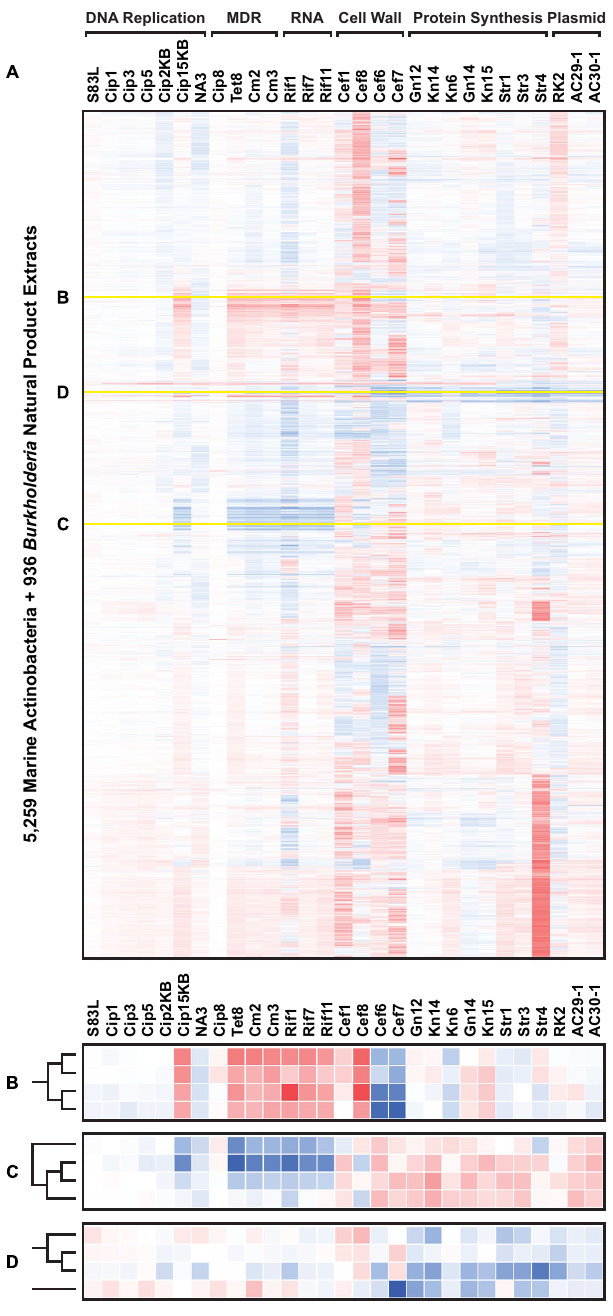
Fig. 3 | Collateral sensitivity pro fi ling of 6195 natural product extracts. A Hierarchical clustering of 5259 marine-derived Actinobacterial and 936 Bur- kholderia natural product extract prefractions (vertical axis) pro fi led against wildtype E. coli and 29 drug-resistant strains (horizontal axis. MDR multidrug resistance, RNA RNA synthesis, Cell Wall cell wall biosynthesis, Plasmid plasmid- borne multidrug resistance). Yellow highlighted lines denote insets B , C , and D with dendrograms. B Zoomed inset showing NP cluster producing CR in mul- tidrug-, rifamycin-, cephalosporin-, and fl uoroquinolone-resistant strains. C Zoomed inset showing NP cluster producing CS in multidrug-, rifamycin-, and fl uoroquinolone-resistant strains. D Zoomed inset showing NP cluster with CS activity in aminoglycoside- and plasmid-borne multidrug-resistant strains. Legend: white = no observable change in percent growth compared to wildtype; red = increase in percent growth compared to wildtype (resistance); blue = decrease in percent growth compared to wildtype (collateral sensitivity). Source data are provided as a Source Data fi